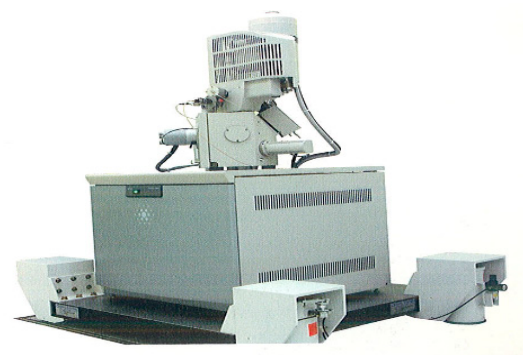
Figure 6. FE-ESEM tester for EDS analysis.